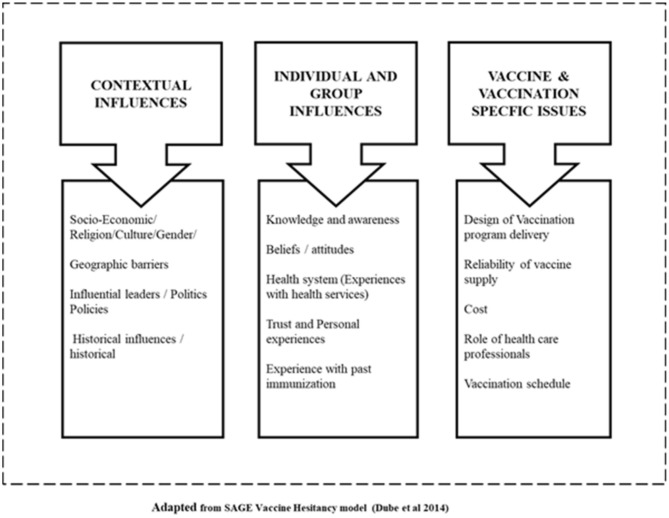
Conceptual framework.